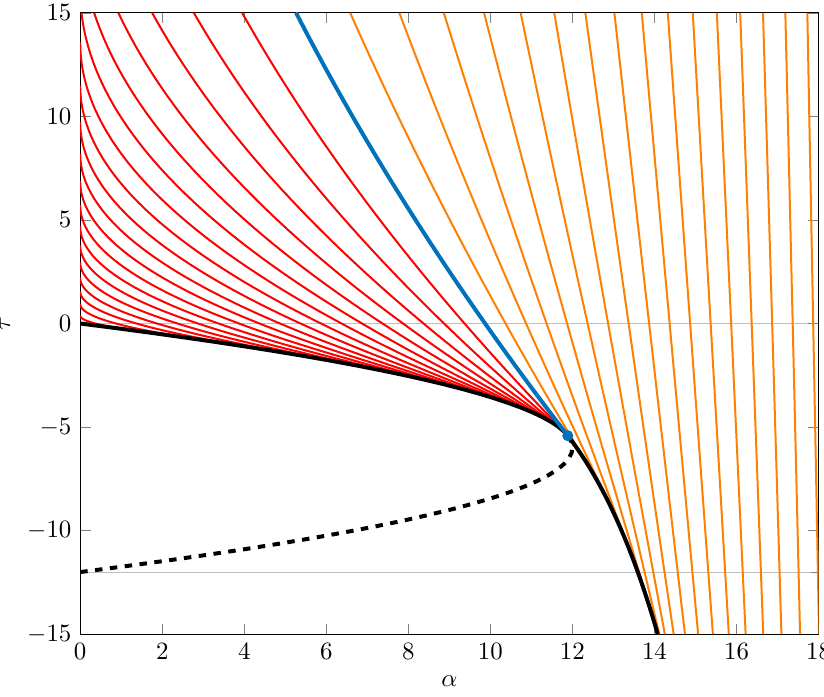
Figure 2 . The diagram shows the system of characteristics associated with both the weak-coupling phase (red lines) and the strong-coupling phase (orange lines). The blue line is the characteristic that acts as a critical line between the two phases and crosses the τ = 0 axis at α = π 2 . The critical line ends on the multicritical point ( α mcp , τ mcp ) . The black parabola delimiting the weak-coupling phase is the envelope of the weak-coupling characteristics and corresponds to α = α w . The black line delimiting the strong-coupling phase is the envelope of the strong-coupling characteristics and has coordinates ( α s , τ s )